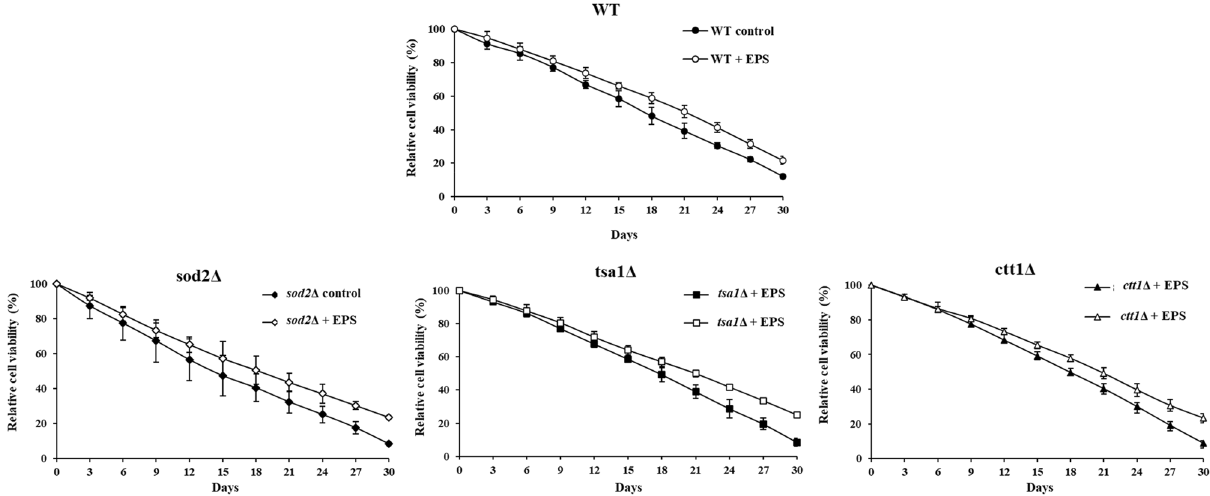
Figure 6. Anti-aging effect of galactan EPS by chronological lifespan assay (CLS) to yeast. WT and superoxide ( sod2∆ ), peroxide ( tsa1∆ ) and catalase ( ctt1∆ ) mutants . Cells were grown in SD with or without EPS for 30 days, and CFU assay was carried out after every 3 days. Data are mean ± SD of three independent